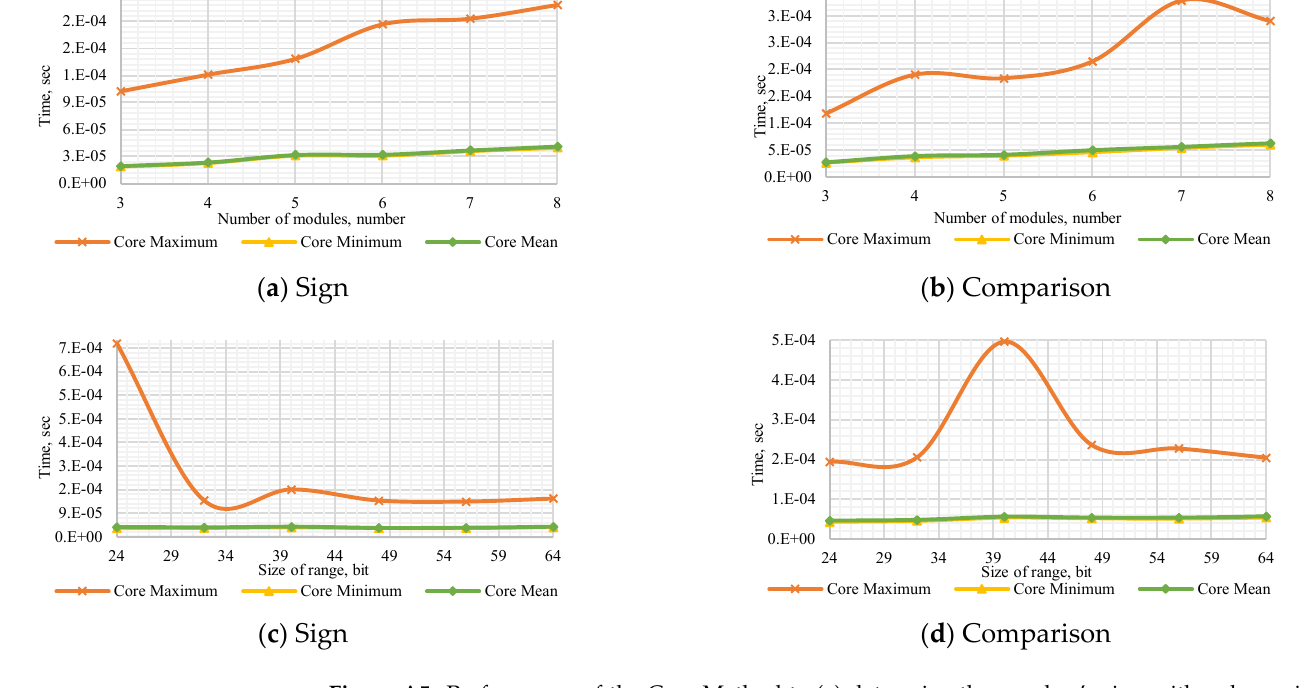
number of modules (cid:1868) , ( b ) compare dynamic numbers of modules (cid:1868) , ( c ) determine the number’s